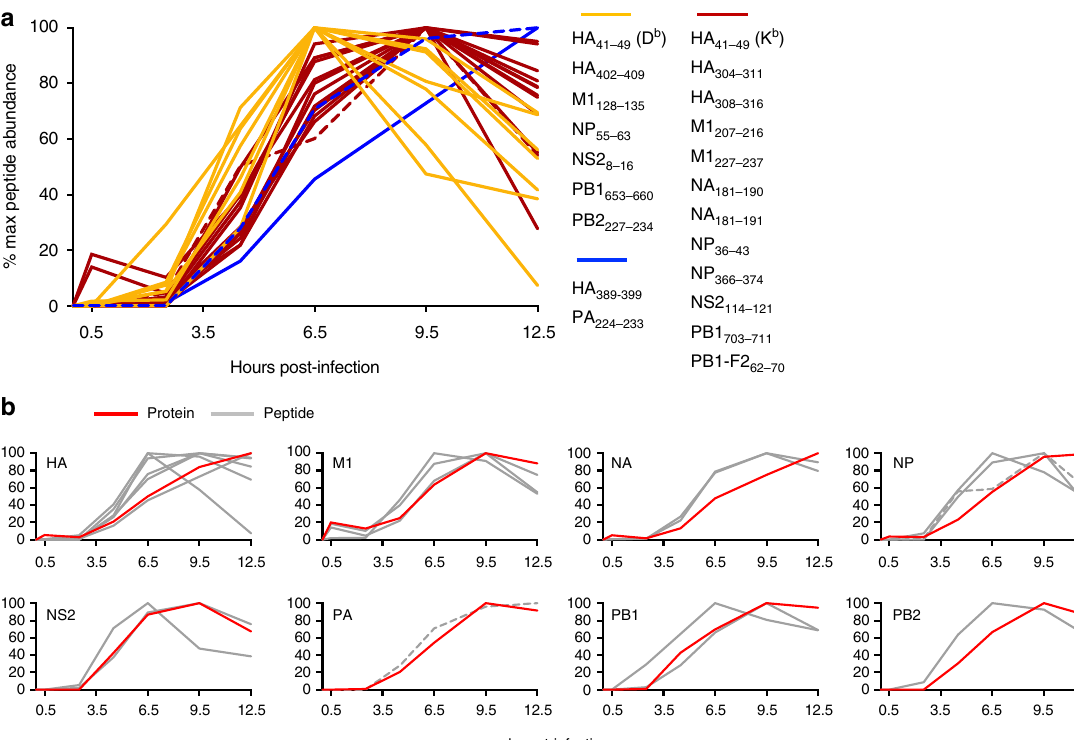
Fig. 2 Kinetics of protein expression and peptide presentation. a The kinetics of peptide presentation were determined by LC-MRM analysis of MHCI- bound peptides isolated from infected DC2.4 cells at 0, 0.5, 2.5, 6.5, 9.5 or 12.5 h post infection. Data are expressed as a percentage of maximum levels detected over the timecourse. Peptides whose abundance peaked at 6.5 h are shown in yellow, those that peaked at 9.5 h shown in red, and those that continued to increase at 12.5 h are shown in blue. b Relative peptide abundance (gray) is plotted alongside relative protein abundance (red) kinetics for the various IAV-derived proteins. Dashed lines indicate the immunodominant NP 366 – 374 and PA 224 – 233